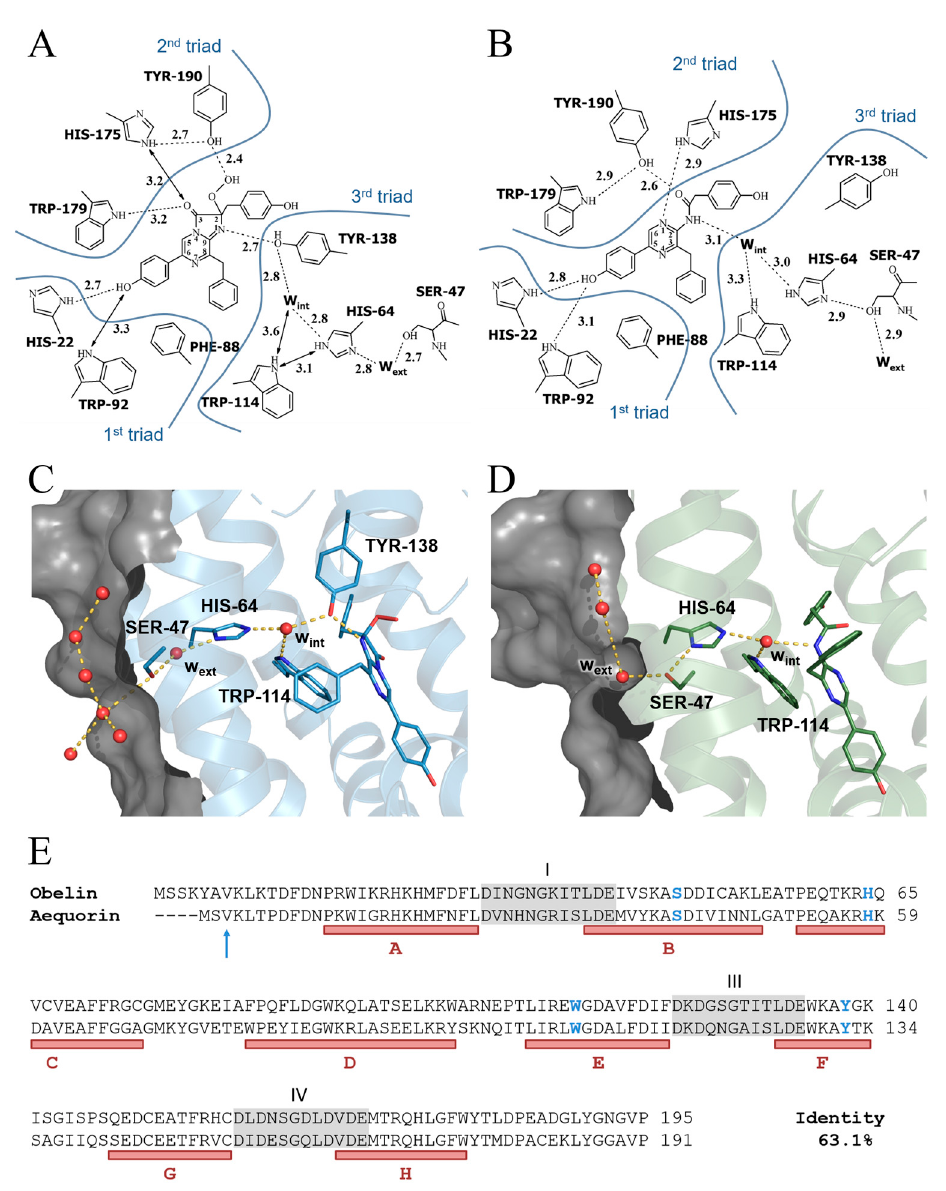
Figure 1. Two-dimensional drawing of the hydrogen bonding network in the binding cavities of active ( A ) and Ca 2+ -discharged ( B ) wild-type obelins. Molecular surface representation of “proton channel” in active ( C ) and Ca 2+ -discharged ( D ) wild-type obelins. Amino acid residues and the molecules of 2-hydroperoxycoelenterazine and coelenteramide are shown as stick models. Water molecules are represented as red balls. Hydrogen bonds are shown as dashed lines. Partially represented surface is gray colored. ( E ) Sequence alignment of obelin from O. longissima [37] and aequorin from A. victoria [38]. The residues in obelin and aequorin mutated in this study are shown in blue. The Ca 2+ binding loops are highlighted in gray. The helices are indicated by capital letters A–H based on the wild-type obelin structure (PDB code 1QV0). Aequorin numeration starts from Val, shown with an arrow, according to the original numbering of the amino acid sequence determined for the natural aequorin and aequorin structure (PDB code 1EJ3)